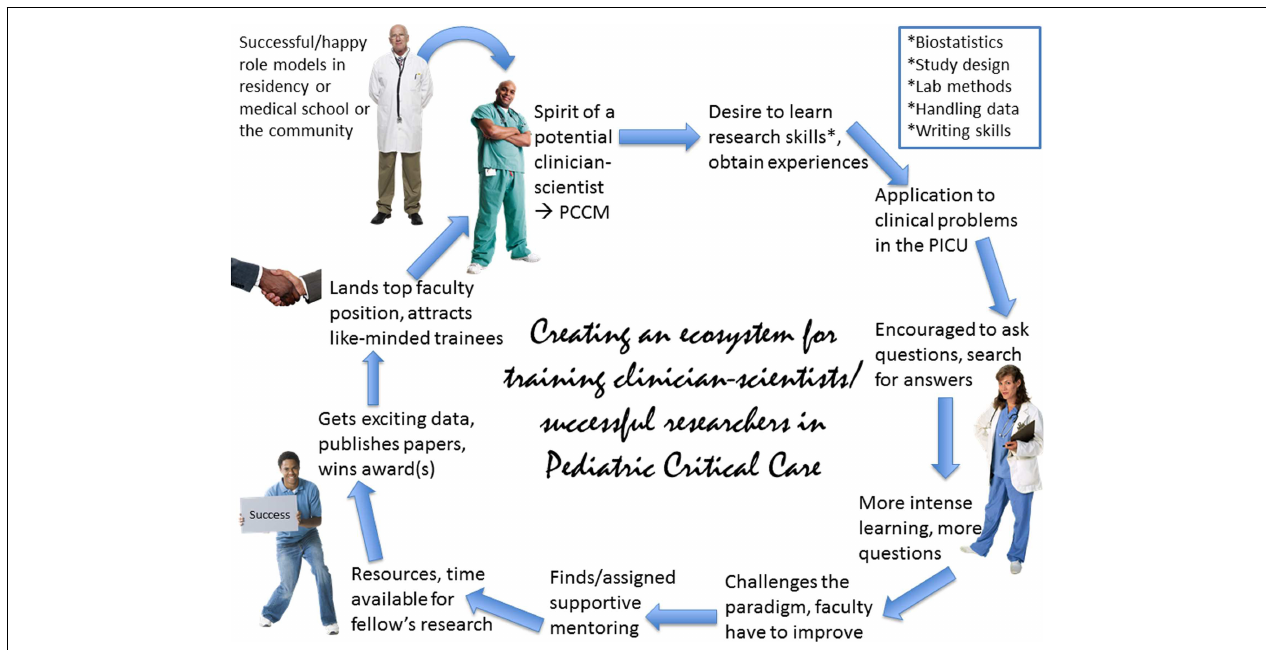
FIGURE 1 | Research-oriented trainees thrive in a challenging and learning environment . Such an environment inspires, nurtures, and prepares trainees to devote their entire career in the pursuit of new knowledge in the basic sciences and/or its clinical applications, or other fields of enquiry.This flow-chart represents the life cycle of such a trainee in a research-oriented department. PCCM, Pediatric Critical Care Medicine; PICU, Pediatric Intensive Care